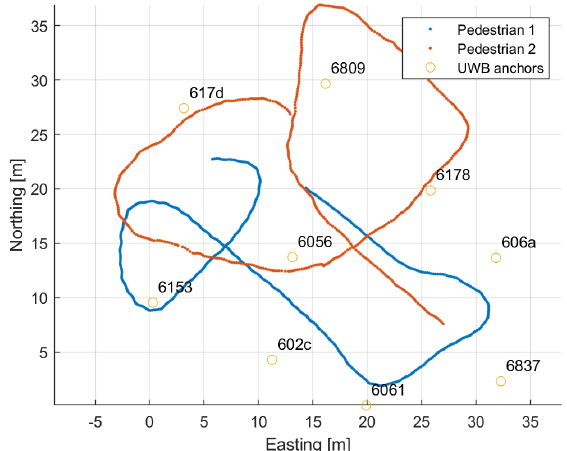
Figure 2. Example of pedestrian GNSS-based reference trajectories.